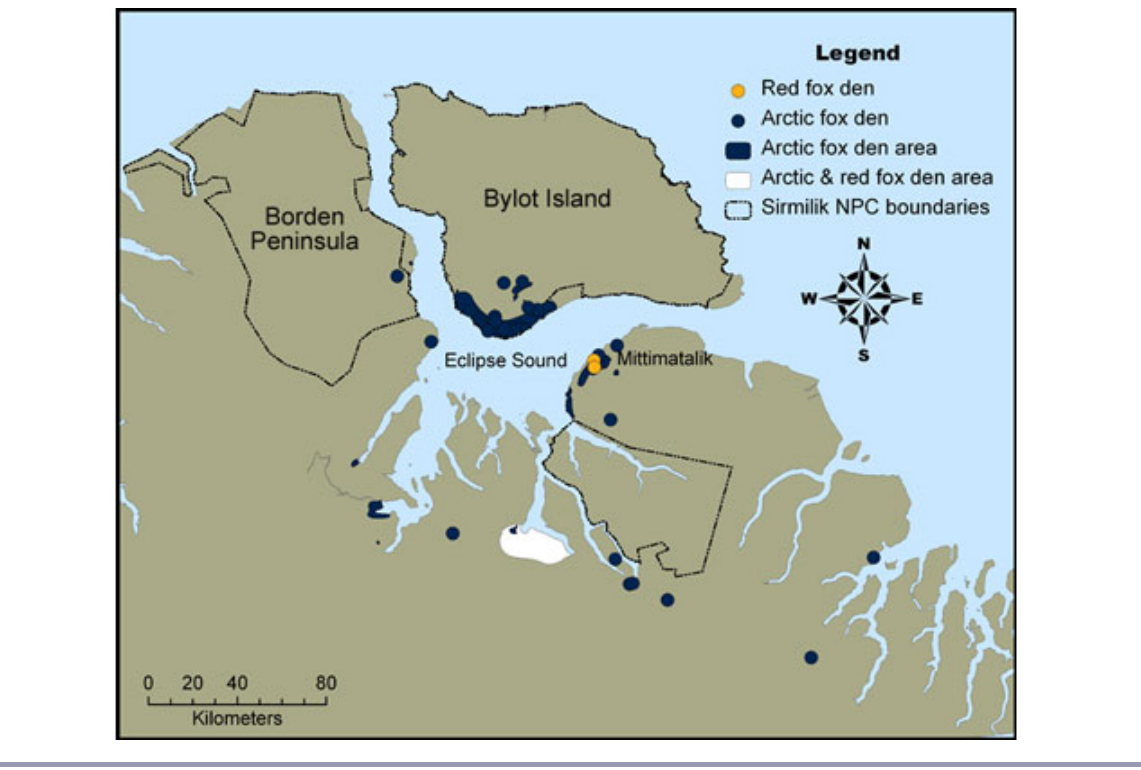
Fig. 4 . Locations of arctic fox ( Vulpes lagopus ) and red fox ( V. vulpes ) dens and denning areas, as reported by the local experts from Mittimatalik, Nunavut, Canada, interviewed in this